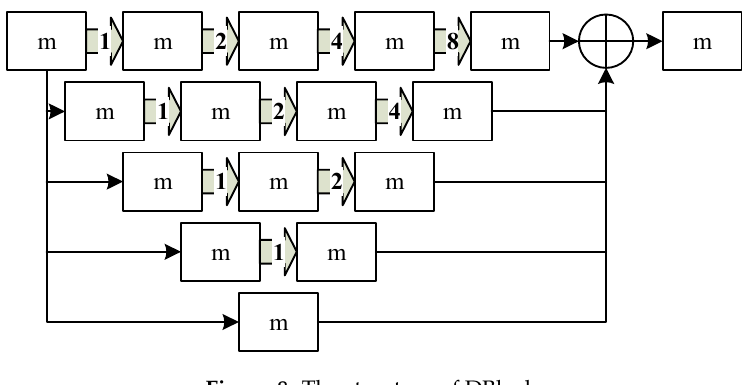
Figure 8. The structure of DBlock.